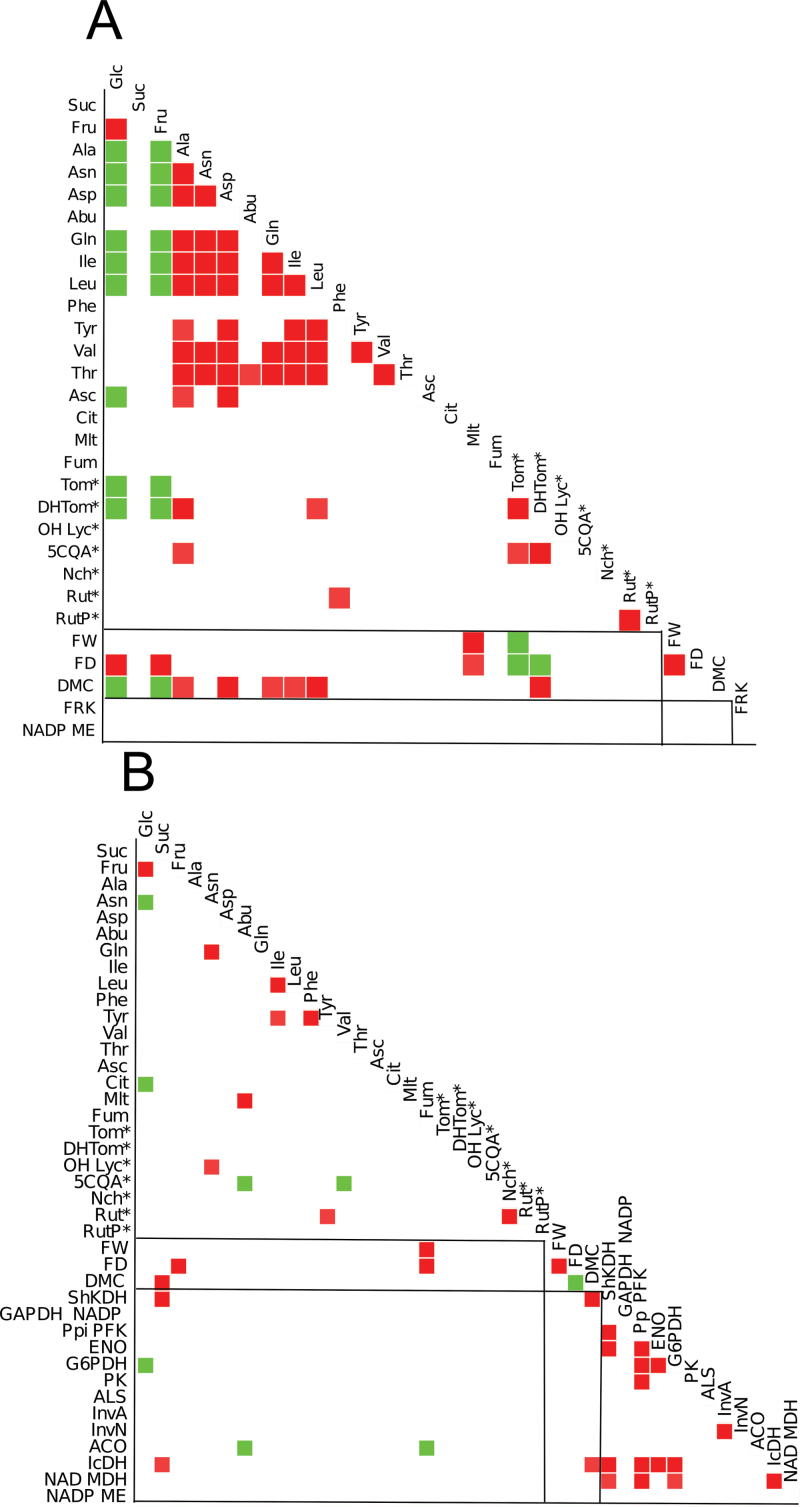
Correlations among significantly variable phenotypic and metabolic traits, and enzyme activities at (A) the cell expansion stage and (B) the orange-red stage. Only correlations where |r|> 0.7 (P-value<0.01) are shown. Dark grey (red) indicates positive correlations; light grey (green) negative correlations. (This figure is available in colour at JXB online.)